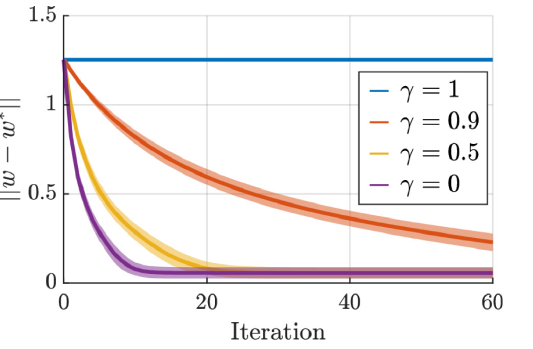
Fig 2. Visualization of the convergence behavior for different values of γ obtained from the random data. Since the null-space and task-space velocities are decorrelated, γ = 0 provides the fastest